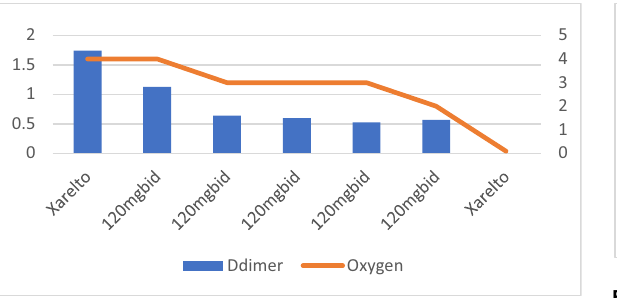
Figure 6: Patient number 6 presented at an early stage requiring nasal canula oxygen and D - dimer level was also low on presenta - tion. The fi gure demonstrates that increase or decrease in D - dimer trends is associated with increasing and decreasing trends of oxygen requirements. This patient was on anticoagulation with Rivaroxaban ( Xarelto ) . The patient was given the required oxygen, but was considered Rivaroxaban failure and converted to full dose of Enoxaparin. The patient was an obese patient, subsequently was discharged home with Rivaroxaban.